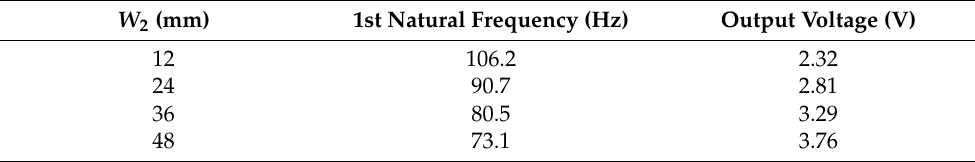
Table 5. The amount of energy harvested in the two-step beam. ( W 1 = W 3 = 12 mm and L 1 = L 2 = 32.5